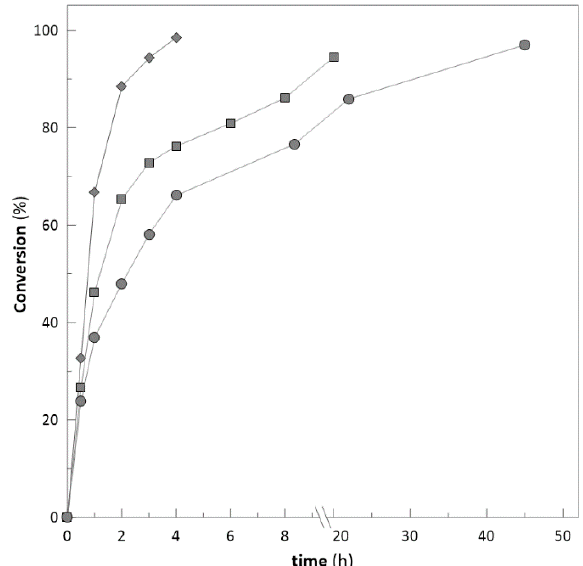
Figure 8. Achieved substrate conversion with different concentration of 4-phenyl-2-butanone ( ♦ 20 mM; ■ 50 mM; ● 100 mM).